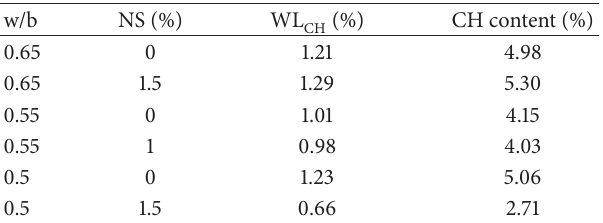
Table 3: CH contents by weight for selected concrete samples, calculated from thermal